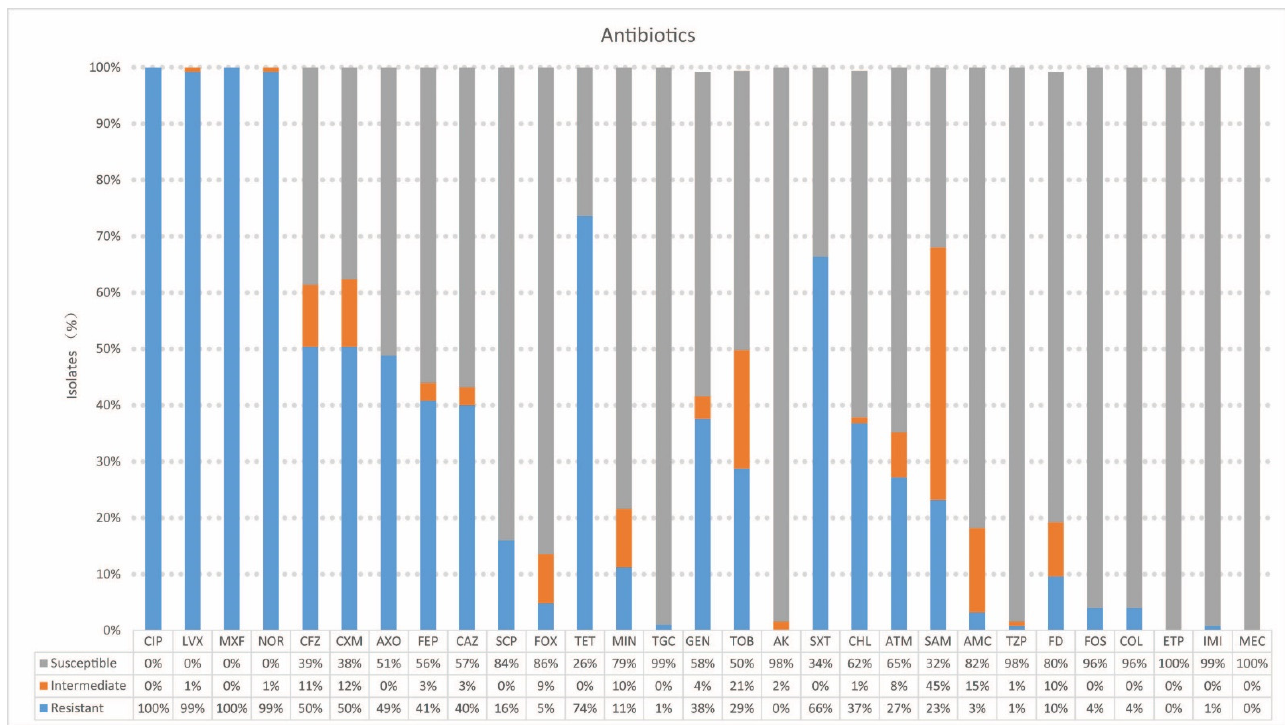
Figure 1. Antimicrobial-resistance phenotypes of the 125 bacterial isolates. Antimicrobial susceptibility testing was as- sessed using the following antimicrobial agents: amikacin (AK), amoxicillin-clavulanate (AMC), ampicillin-sulbactam (SAM), aztreonam (ATM), cefazolin (CFZ), cefepime (FEP), cefoperazone-sulbactam (SCP), cefoxitin (FOX), ceftazidime (FEP), ceftriaxone (AXO), cefuroxime (CXM), chloramphenicol (CHL), CIP, colistin (COL), ertapenem (ETP), fosfomycin with G6P (FOS), gentamicin (GEN), imipenem (IMI), levofloxacin (LVX), meropenem (MEC), minocycline (MIN), moxi- floxacin (MXF), nitrofurantoin (FD), norfloxacin (NOR), piperacillin-tazobactam (TZP), tetracycline (TET), tigecycline (TGC), tobramycin (TOB), and trimethoprim-sulfamethoxazole (SXT).